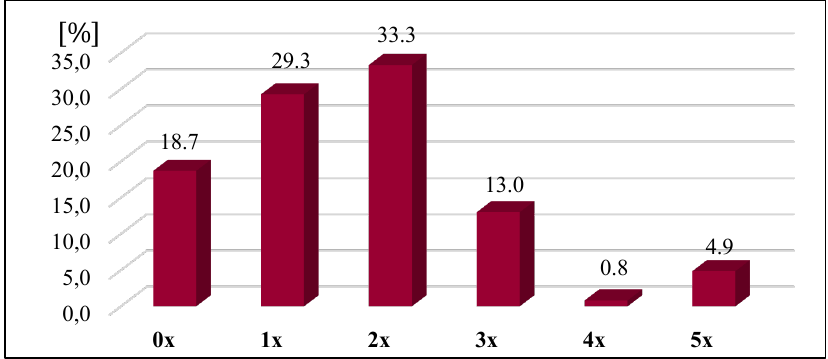
Fig. 3. Results in answers to the item no.2: “Mention in which school years you had the subject of Technical educatioN“